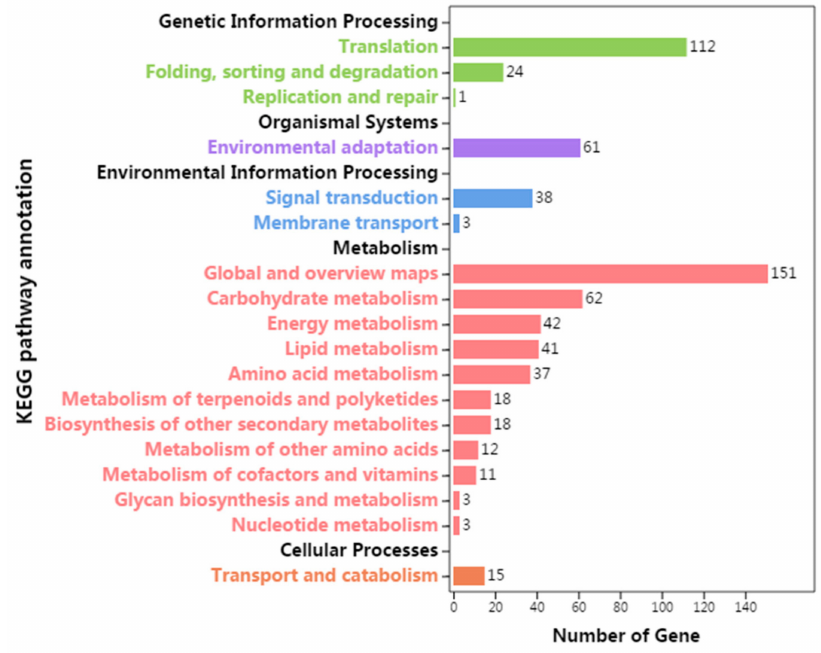
Figure 6. KEGG pathway annotation of di ff erentially expressed genes